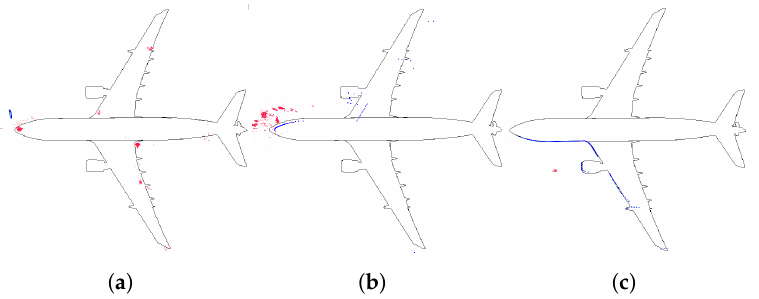
Figure 8. AMCL convergence process. Two-dimensional laser scan (blue), AMCL particle cloud (red). ( a ) UAV takes off, particles are distributed all over the map. ( b ) UAV moves forward, particle scattering begins to decrease The 2D laser scan does not match the map. ( c ) AMCL converges, particle scattering is small, and the laser data matches the map. Table 1. Calculation of ATE at different altitudes for 20 simulated flights.